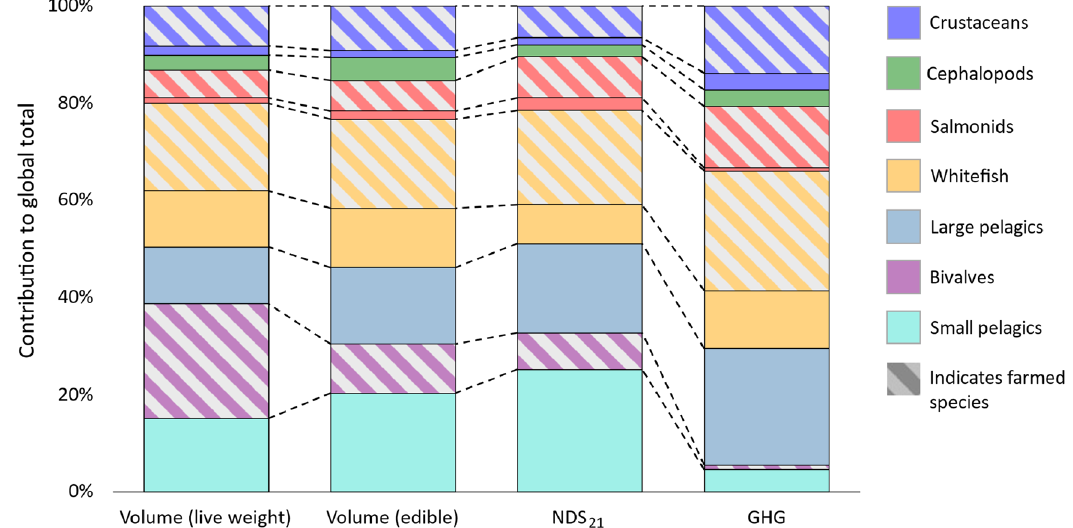
Fig. 5 Contribution of seafood groups to harvest, food production, nutrition and greenhouse gas emissions. Contribution of seafood groups to global production volumes in 2015 expressed on a live and edible weight basis (for species-speci fi c edible yields see Supplementary Table 6), nutrient density (NDS 21 ) and GHG emissions, all weighted by species within each seafood group. Solid groups consist of wild-caught, striped ones of farmed